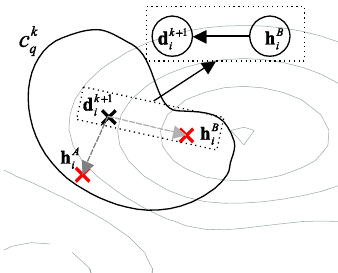
Figure 2. The effect of local perturbation operation.